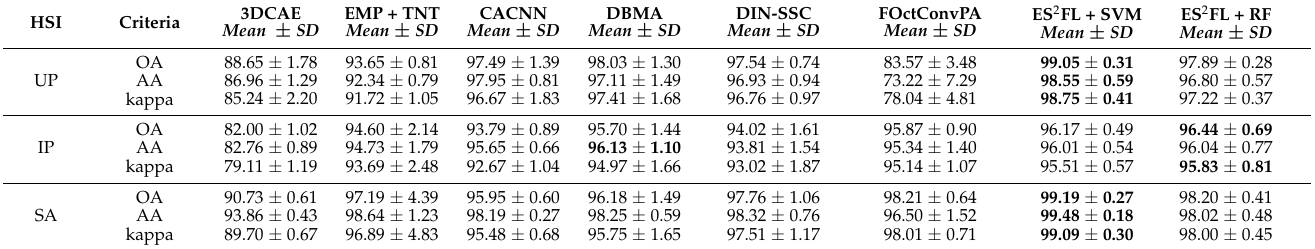
Table 7. The classification results of different methods with sufficient samples. SD denotes the standard deviation of 10 experimental results.